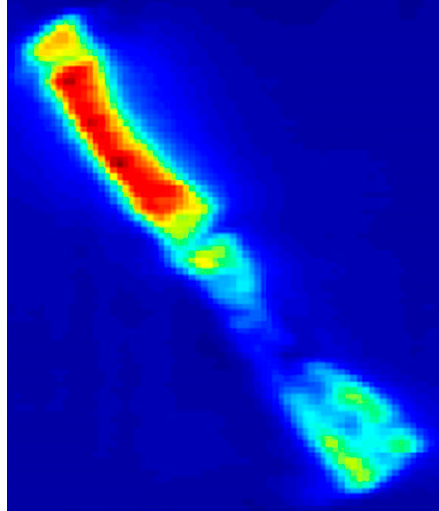
Figure 5. The occlusal view of Micro computerized calvaria after 8 weeks.